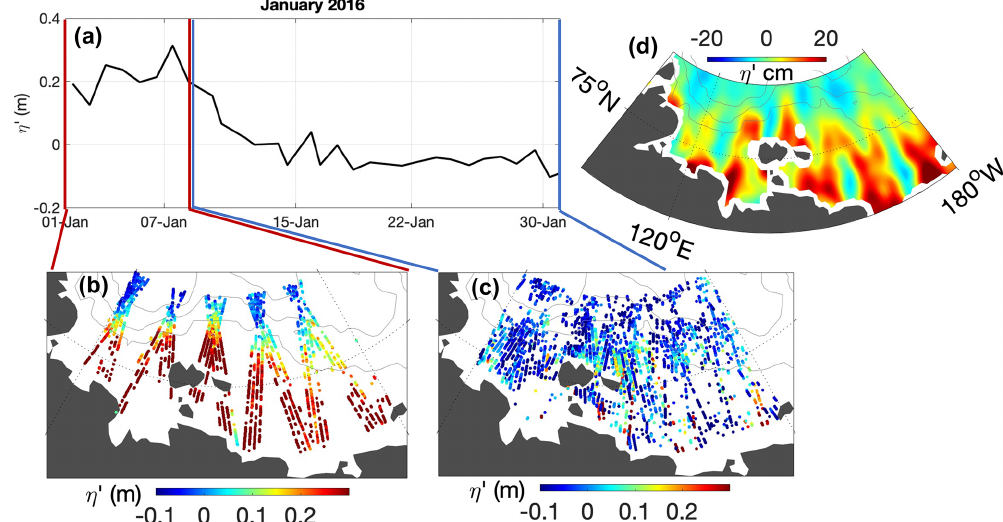
Figure C1. Trackiness introduced by sub-monthly variability. (a) Time series of average along-track η (cid:48) in the East Siberian Sea and Laptev Sea for the month of January 2016. (b, c) Scattered along-track η (cid:48) in the periods of (b) 1–8 January and (c) 9–31 January. (d) η (cid:48) field for the month of January 2016 if interpolation is performed on a monthly set of